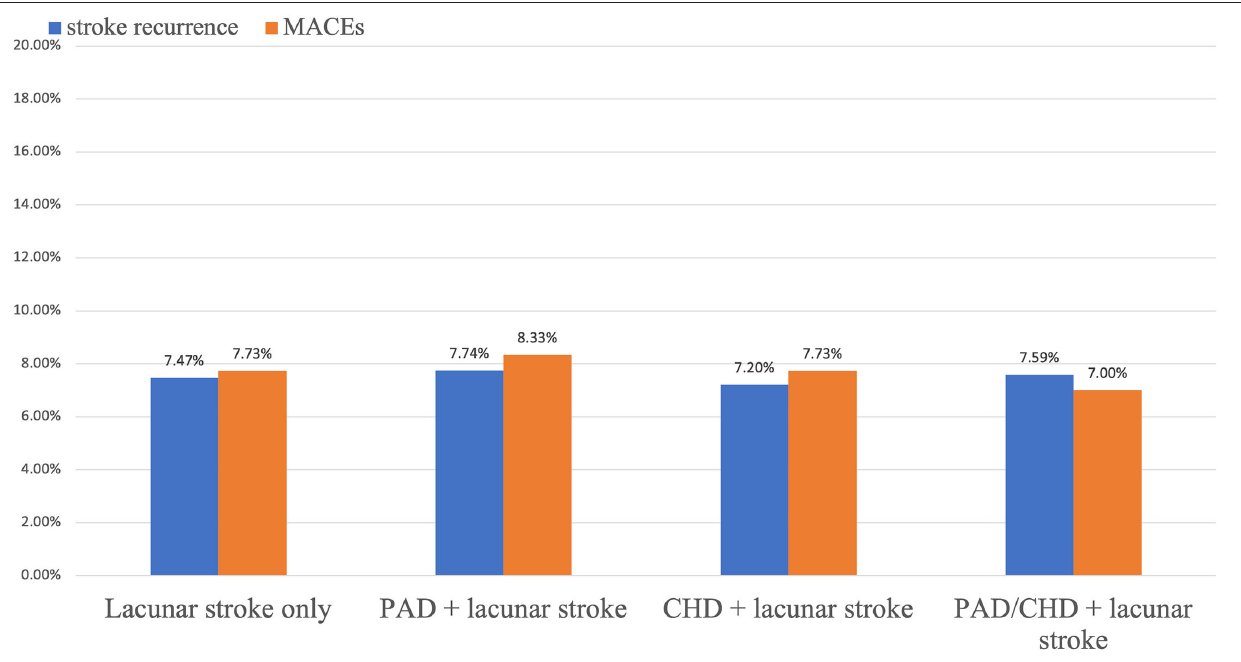
FIGURE 2 | Rates of stroke recurrence and MACEs in patients with recent lacunar stroke.